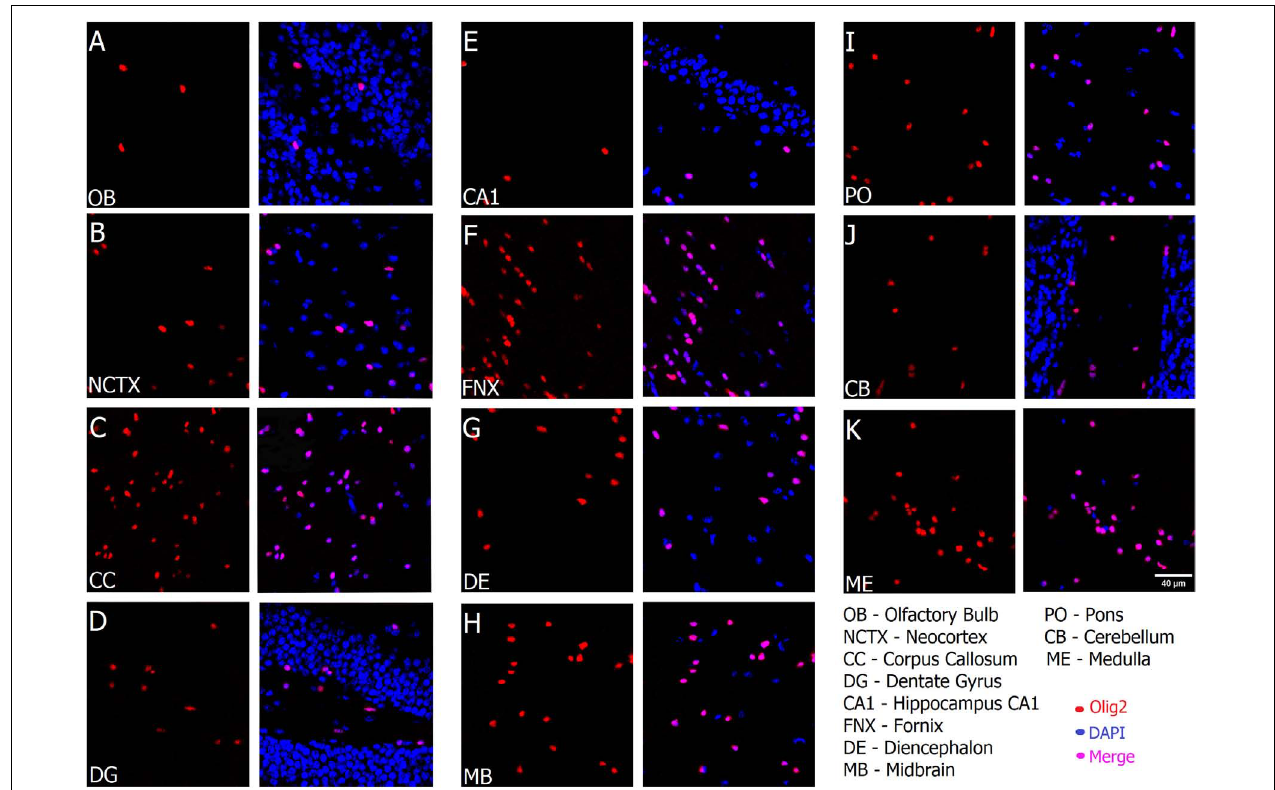
FIGURE 2 | Oligodendrocytes are present in all regions of the mouse brain. From (A–K) , Olig2 (red) merged with DAPI (blue) and is detected in all anatomical compartments, including brain regions that originated from different embryonic subdivisions, and in both gray and white matter, in parasagittal frozen slices. Scale bar (same for all fields): 40 µ